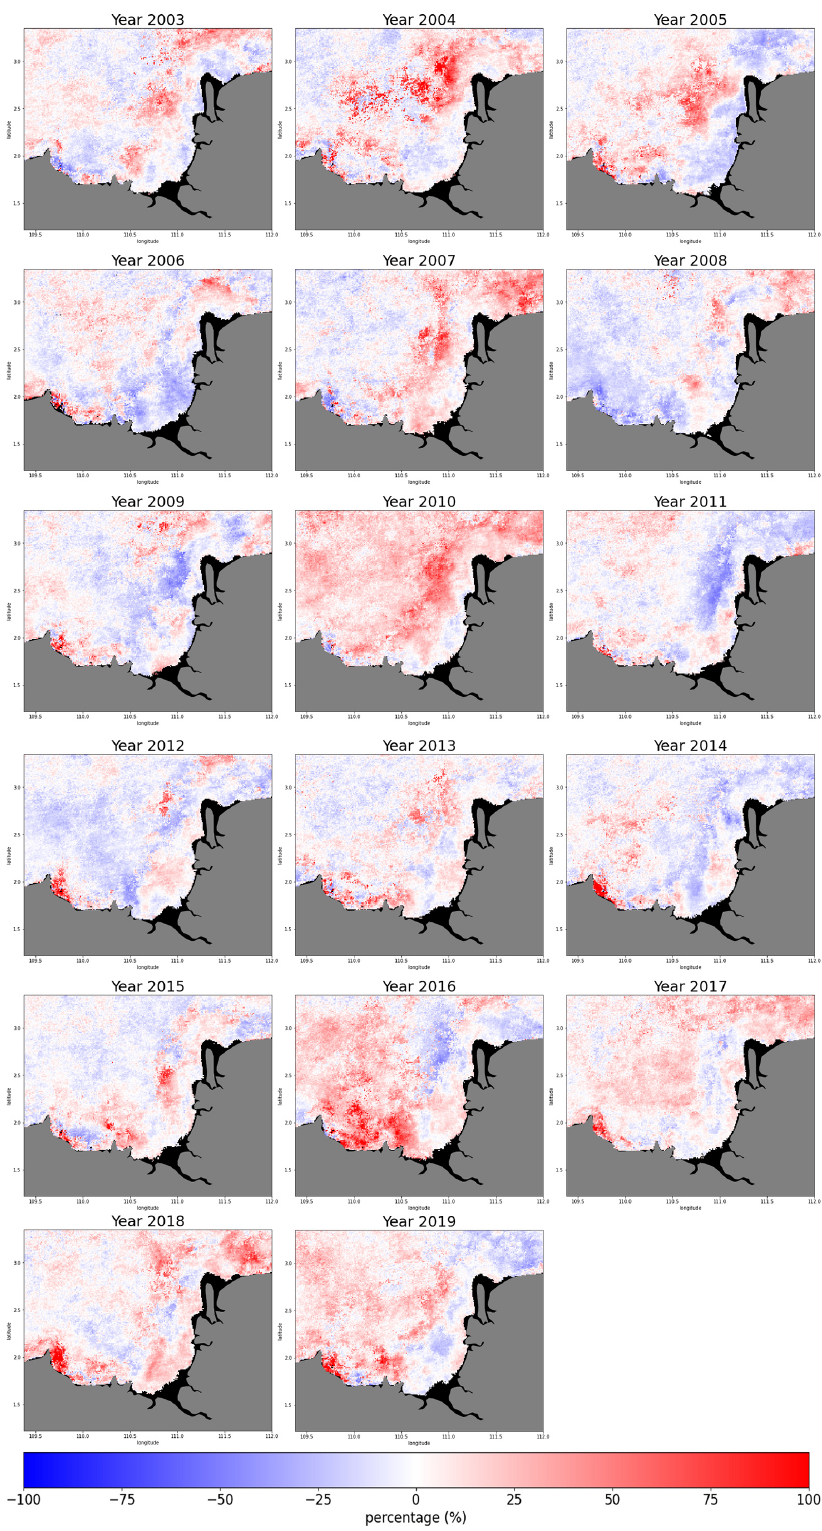
Figure 8. Map of relative TSS distribution anomalies with respect to the long-term mean, represented as a percentage (%), from the year 2003 until